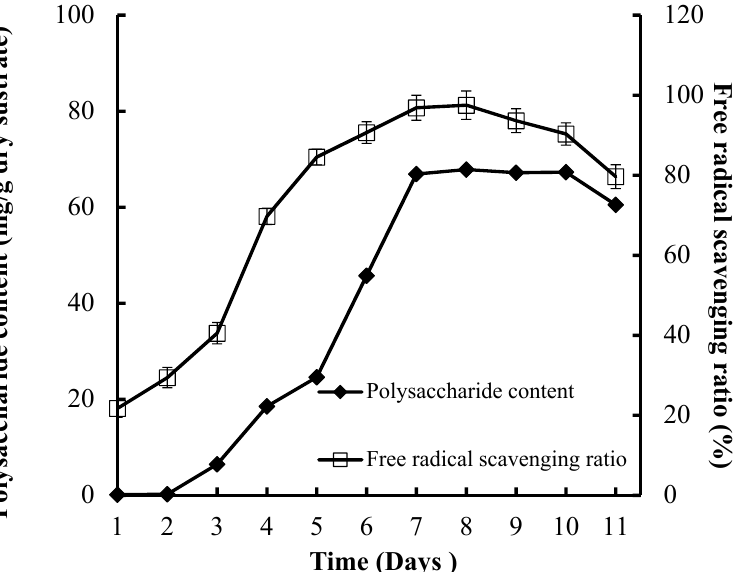
Figure 4. E ff ect of culture time on CPS production and antioxidant activities of Figure 4. Effect of culture time on CPS production and antioxidant activities of substrate.